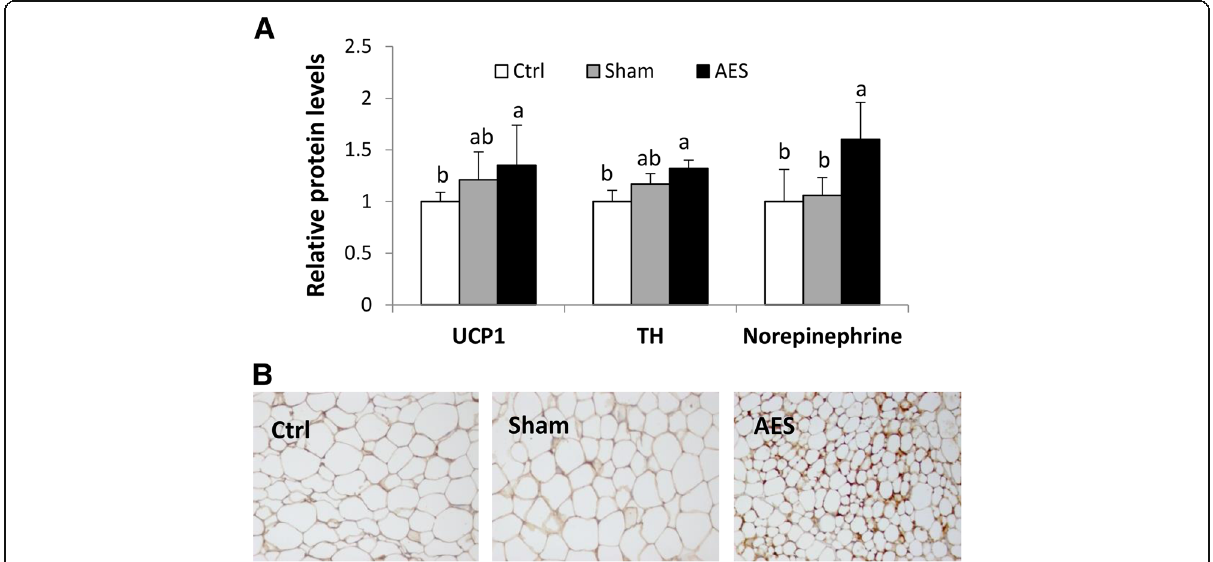
Fig. 3 Protein levels of markers associated with thermogenesis and sympathetic innervation ( a ) and IHC staining for UCP-1 ( b ) in inguinal WAT of mice in three groups. In ( a ), Data are mean±SD, n=8. In ( b ), the comparison was based on the protein levels relative to Ctrl (taking as 1). a,b Means without a common letter differed ( P